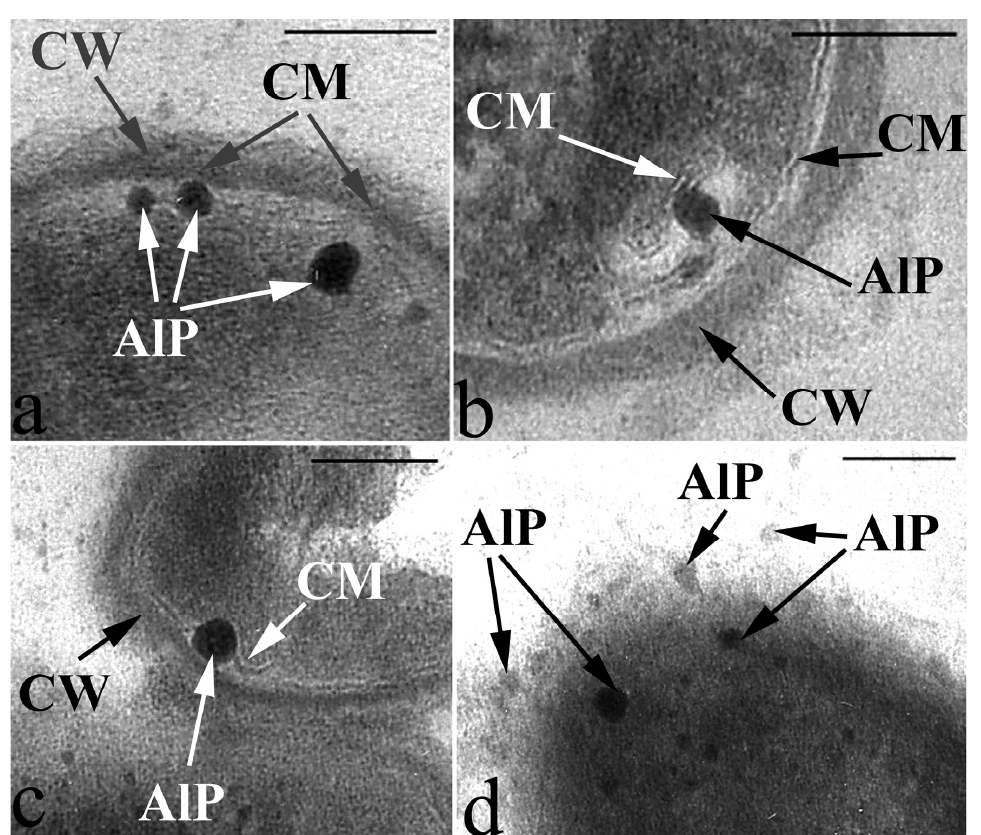
Figure 5. Peculiarities of acidocalcisome-like particles (AlP) localization as they are released from the cell into the environment in resting cells of G . polyisoprenivorans 135. ( a ) AlP in the cell cytoplasm on the inner surface of the cytoplasmic membrane (CM); ( b ) AlP inside the invagination of the CM on its outer surface; ( c ) AlP in the space between the cell wall (CW) and CM; ( d ) AlP in the extracellular space. Transmission electron microscopy (fragments of ultrathin sections). Designations: CM— cytoplasmic membrane; CW—cell wall; AlP—acidocalcisome-like particules. Bar—100 nm.